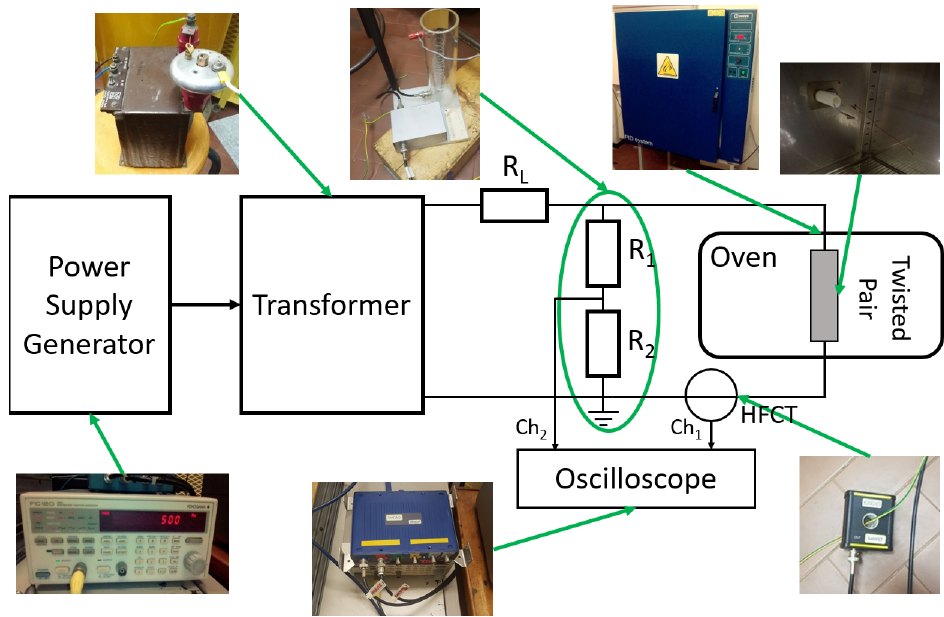
Figure 3. Measurement system. Table 3. Sub-datasets